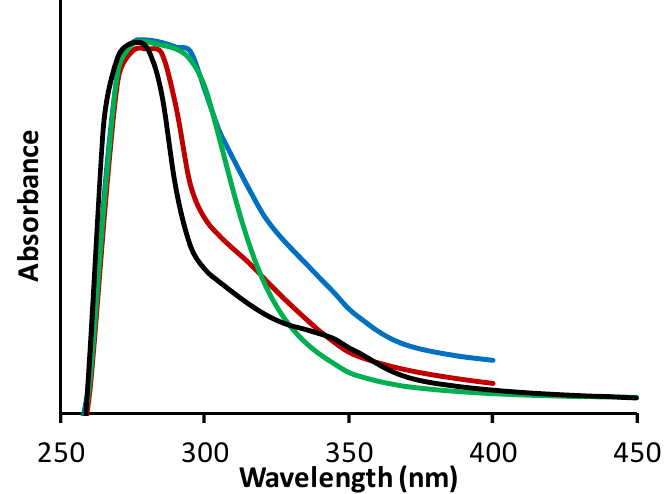
Figure 4. UV absorbance profiles of various tannin esters. Tannin (in water, pH7, blue), tannin acetate (in chloroform, red), tannin hexanoate (in dimethyl formamide, green) and tannin hexanoate acetate (in DMF,